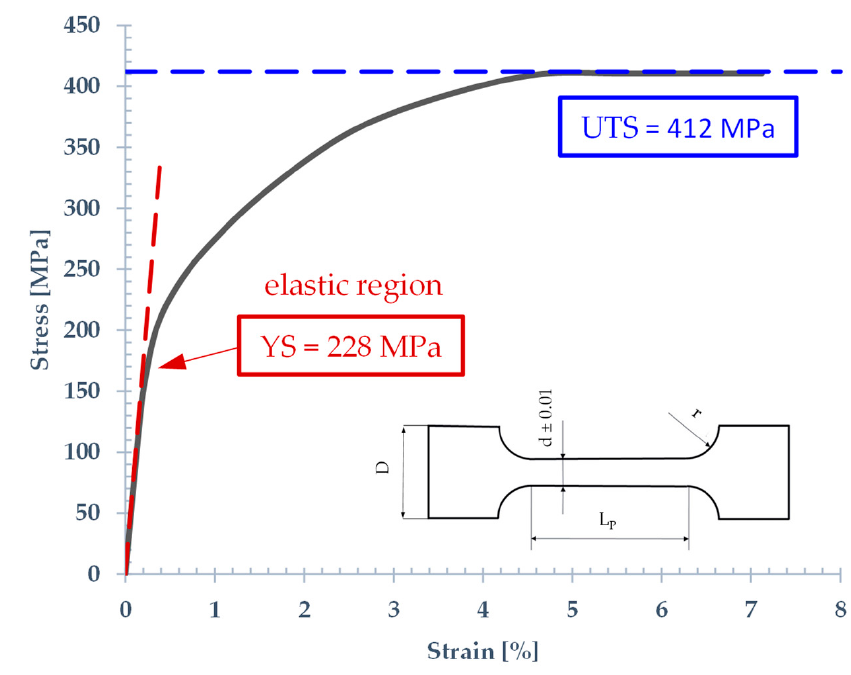
Figure 3. Tensile test curves of LPBF processed AlSi10Mg alloy [54,55].